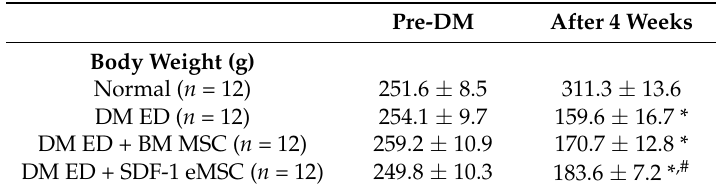
Table 1. Body weights and serum glucose